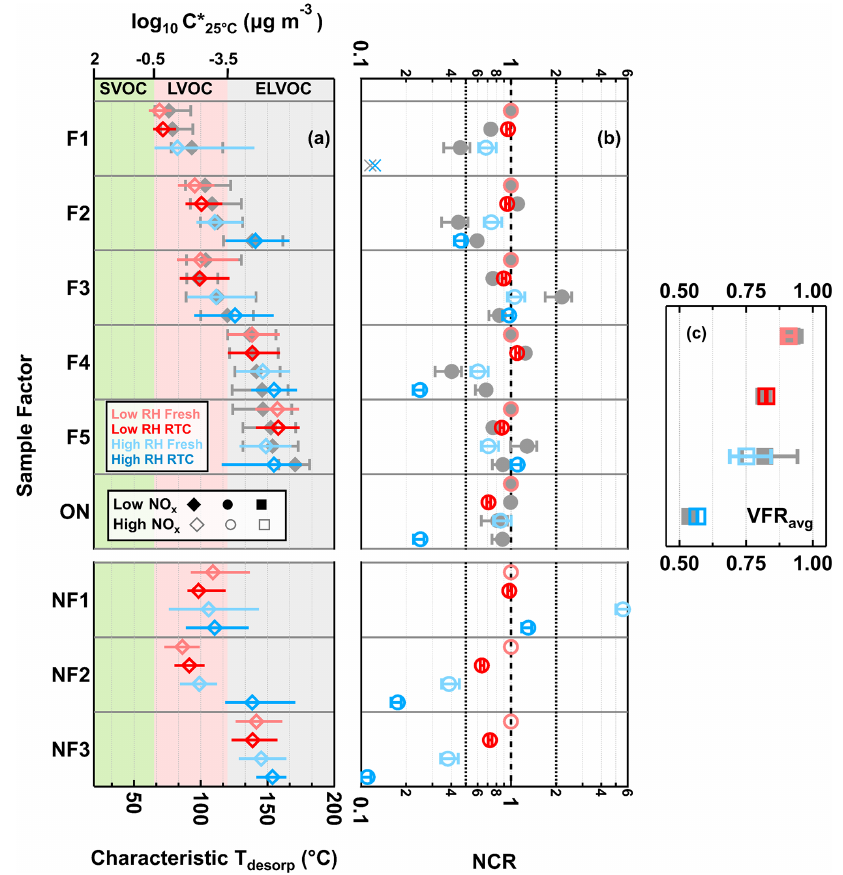
Figure 7. Volatility and changes in factor contribution for the five CHO and three ON sample factors and total ONs (sum of ON sample factors). (a) Characteristic desorption temperature (characteristic T desorp ). The marker indicates the T 50 values, and the horizontal lines mark the interquartile range of the factor thermograms. (b) Net change ratio (NCR) with error bars indicating the uncertainty stemming from the estimated range in molecular weight and particle density. (c) Average volume fraction remaining during sample collection (VFR avg ), with error bars indicating the minimum and maximum values. In all panels, the values for the high NO x case are shown with colored markers, while the low NO x ones are displayed in gray. The colors indicate the sample type. The order of samples is identical for the low NO x and high NO x data. (a) The range of volatility classes is highlighted with background colors. (b) The dashed line at NCR equal to 1 indicates that any loss is counterbalanced by production or that no change occurs. The two dotted lines at NCR equal to 0.5 and 2 represent significant net loss and production. For F1, its factor thermogram contributes less than 5% to the total sample signal and does not show a clear maximum under the high RH and RTC condition. Therefore, its characteristic T desorp value was not estimated in panel (a) , and its NCR was be indicated by a cross close to the 0.1 in panel (b)